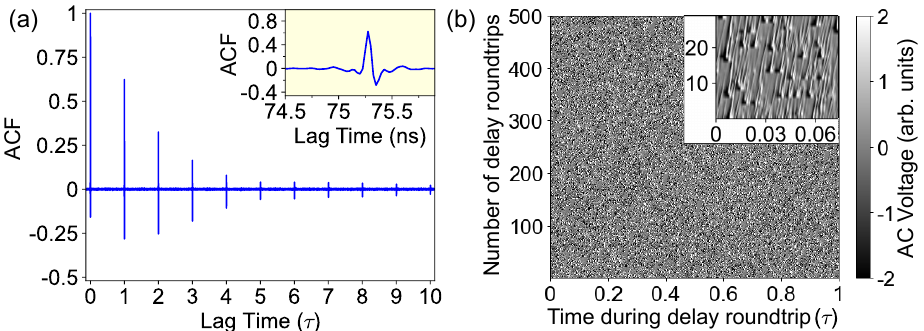
Figure 5. Different representations of the chaotic intensity dynamics of delayed feedback lasers. ( a ) The autocorrelation function (ACF) corresponding to the same feedback conditions as depicted in the intensity dynamics of Figure 4b. The ACF was calculated over a time series of 2 million samples recorded with a sampling rate of 40 GS/s. ( b ) The spatio-temporal representation of the same chaotic time series. The abscissa denotes the time offset in a delay interval of length τ , while the vertical axis stacks the time series segments of length τ . The magnitude of the intensity fluctuations is